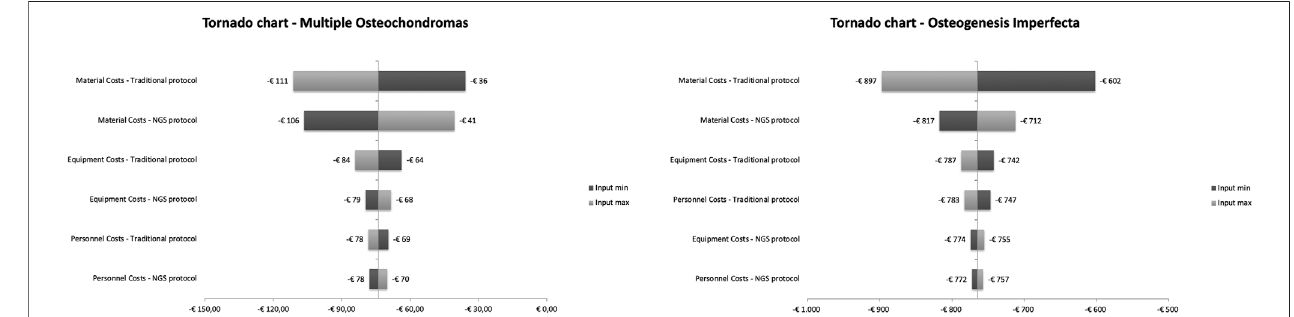
FIGURE 1 | One-way sensitivity analyses to evaluate changes in savings of total